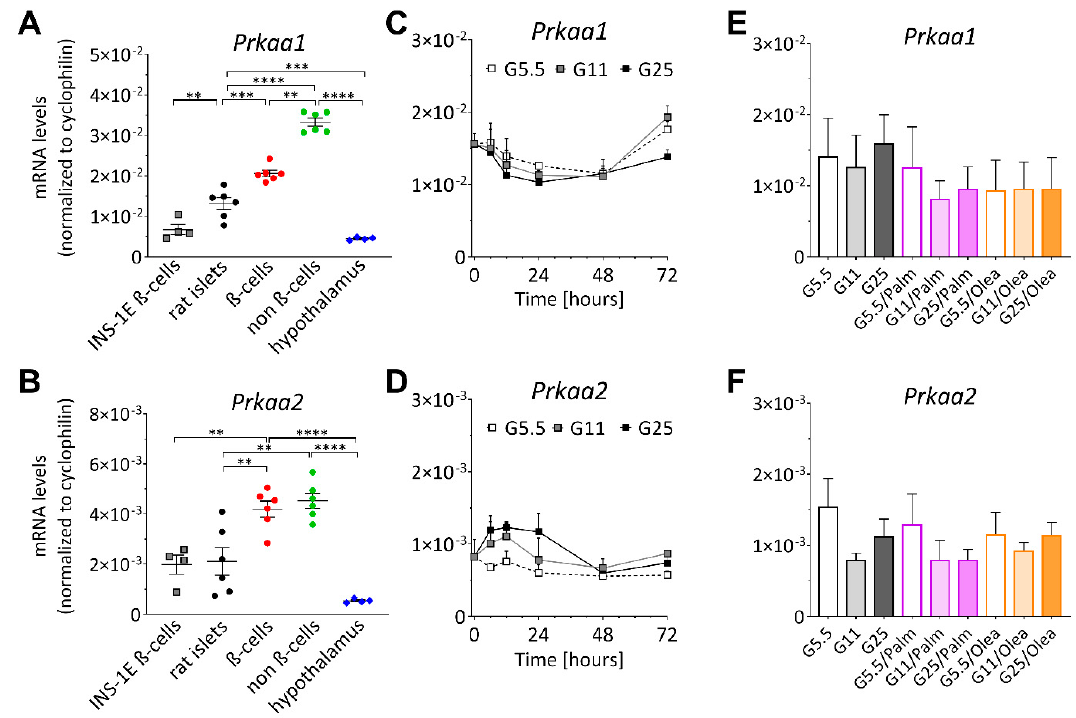
Figure 2. AMPK mRNA levels in rat islets and in INS-1E β -cells under metabolic stress conditions. ( A – B ) Relative expression of the two components of the AMPK catalytic subunits α 1 and α 2, encoded by the Prkaa1 and Prkaa2 genes, respectively; measured by qRT-PCR and normalized to cyclophilin ( n = 6); ** p < 0.01, ** * p < 0.005, **** p < 0.001. ( C – D ) Time course of the transcript levels in INS-1E β -cells after low (G5.5), control (G11) and high (G25) glucose exposure ( n = 3). ( E – F ) Cells were treated for 3 days with 0.4 mM palmitate (Palm) or oleate (Olea) in the presence of 0.5% BSA ( n =